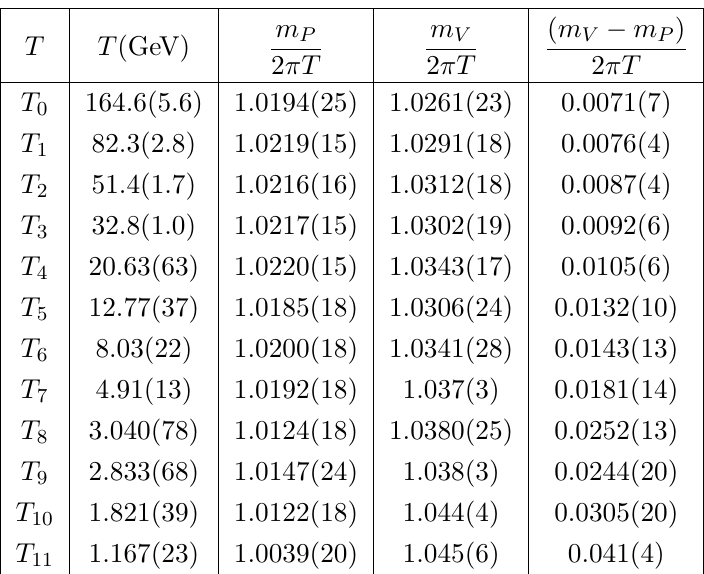
Table 1 . Best results for the pseudoscalar, m P , and the vector, m V , non-singlet screening masses in the continuum limit together with their